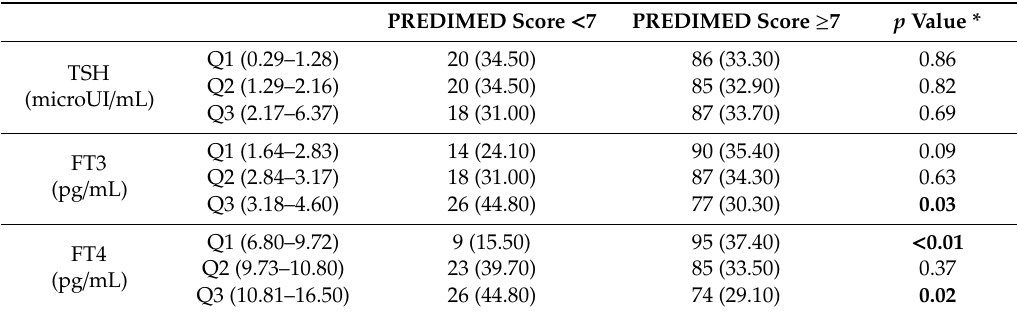
Table 3. Distribution across thyroid hormones tertiles according to the PREDIMED (PREvenci ó n con DIeta MEDiterr á nea)